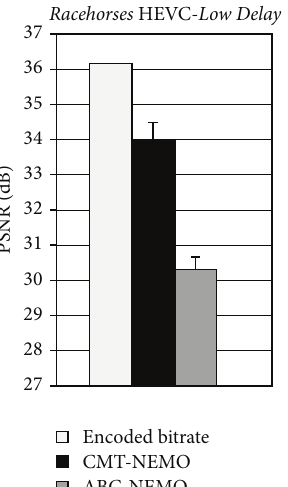
Figure 17: Comparison using HEVC at 2252